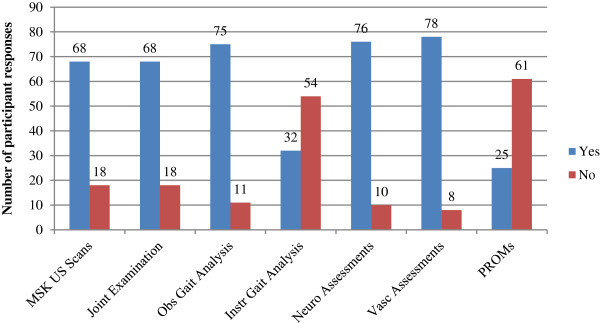
Bar chart indicating the number of ‘yes/no’ responses to the question regarding foot health assessments “Do your patients have adequate access to services providing for these needs:-”.